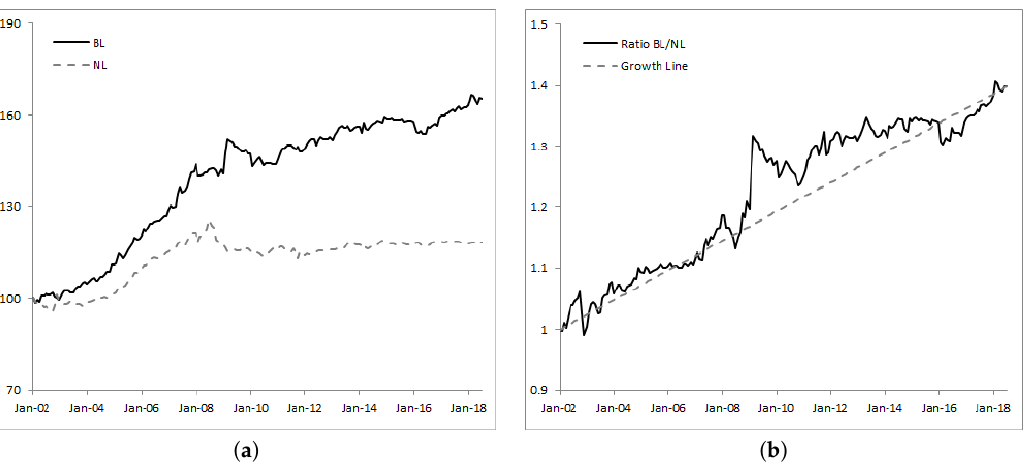
Figure 7. Historical values of the portfolios calculated with both w BL and w NL under the Base Case ( a ) and their ratio ( b